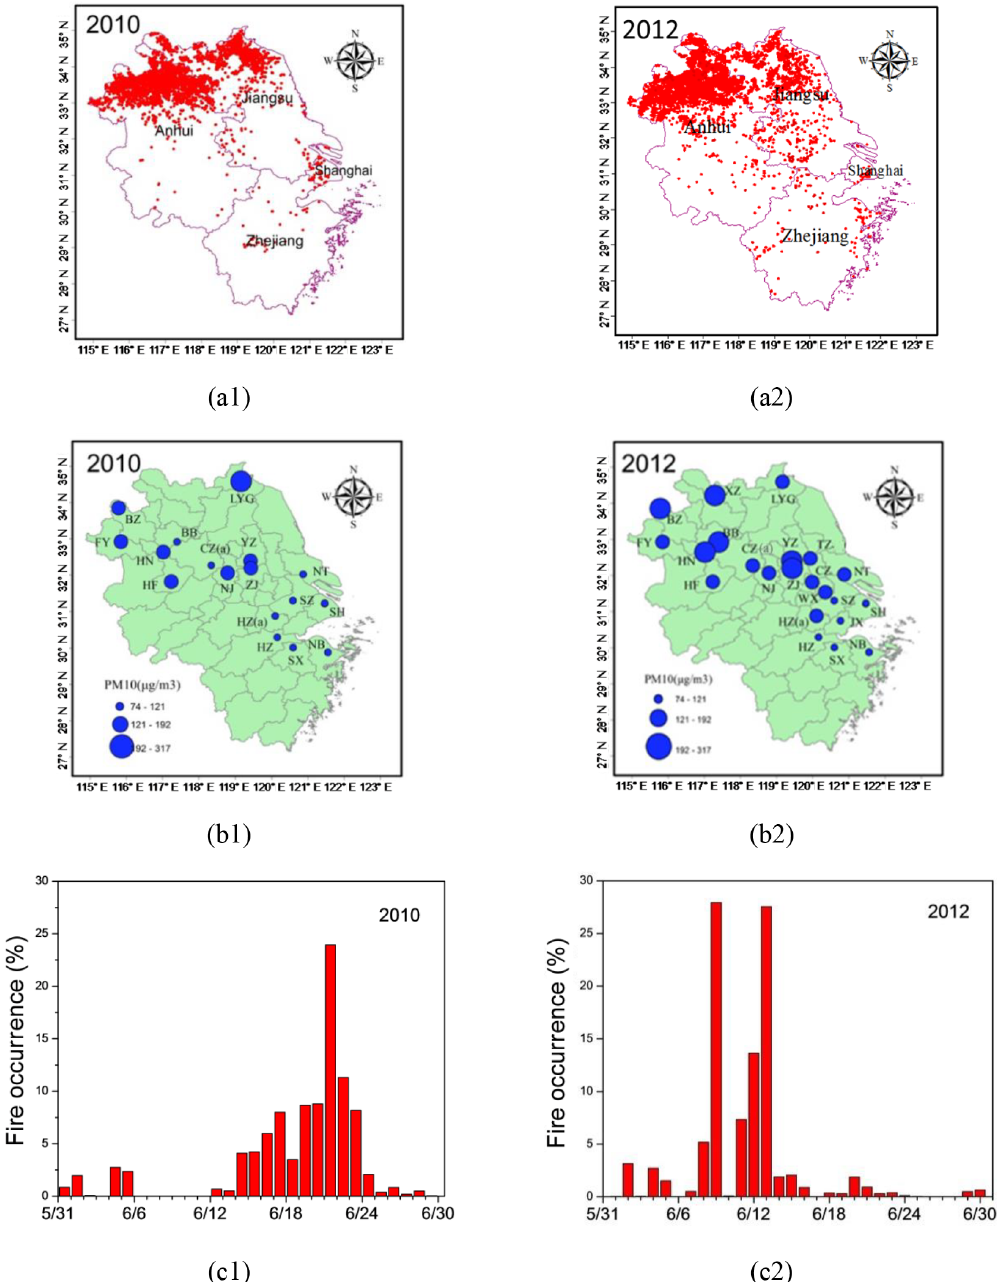
Figure 1. (a) Spatial patterns of fire points in June 2010 and June 2012, (b) PM 10 concentrations for the city level in the YRD in June 2010 and June 2012, and (c) temporal variations in daily fire occurrences in June 2010 and 2012. City abbreviations FY, BZ, BB, HN, HF, CZ(a), XZ, LYG, NJ, YZ, ZJ, TZ, NT, CZ, WX, SZ, HZ(a), JX, HZ, SX, NB and SH indicate Fuyang, Bozhou, Bengbu, Huainan,